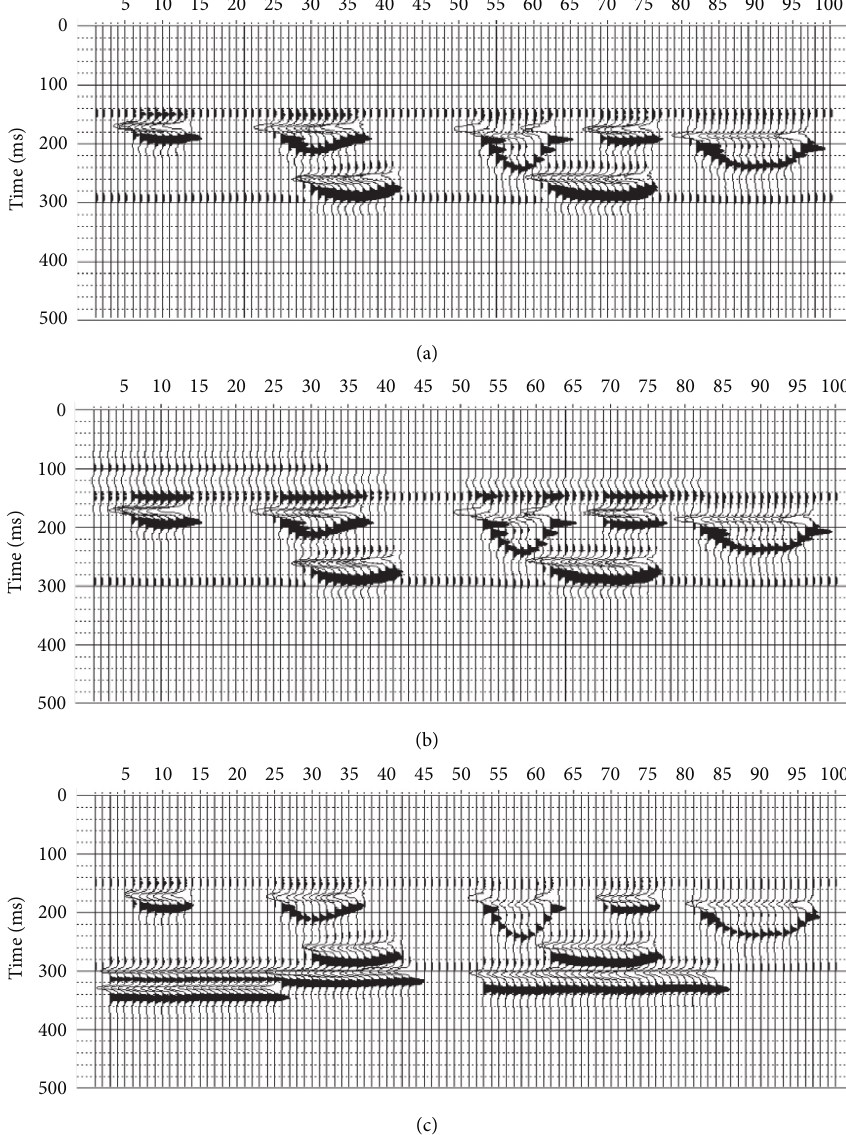
Figure 4: Synthetic seismic records of different 2D channel geological models at 20Hz. (a) Noninterference. (b) Upper interference. (c) Lower